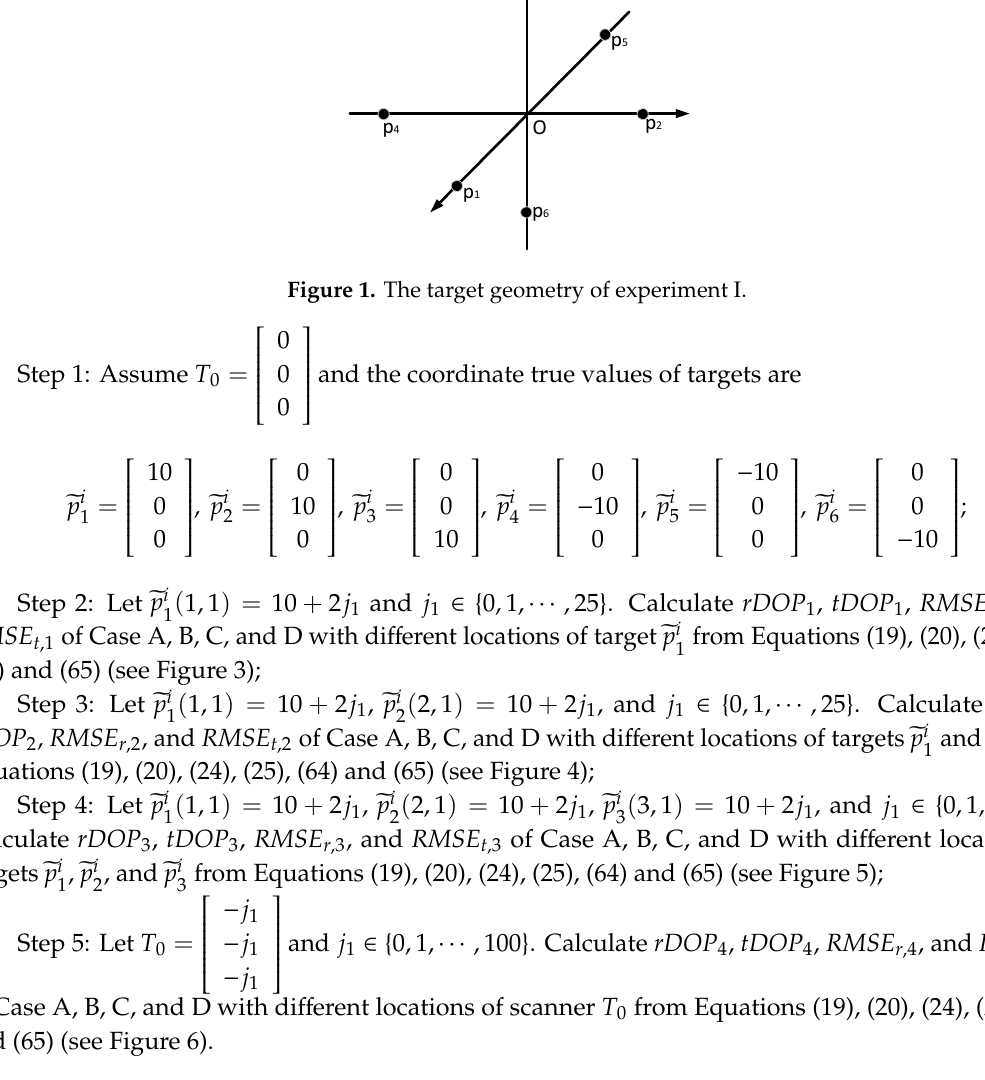
Figure 2. The target and scanner i + 1 geometry of experiment II.